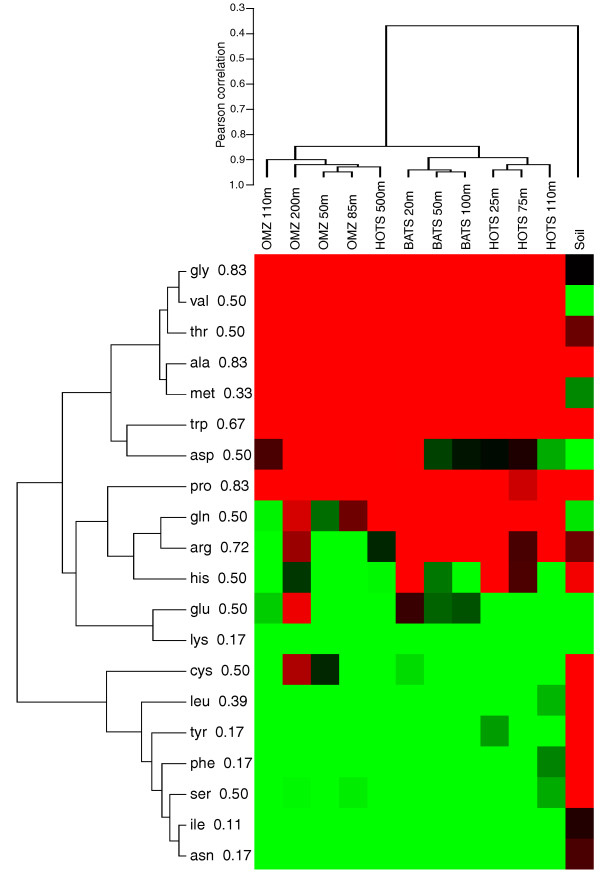
Clustering of sample datasets based on proportional amino acid change. Heat maps show the relative magnitudes of the proportional change (from DNA to RNA) in each sample set. Red = increase, green = decrease, black = zero. Dendrograms are based on hierarchical clustering of Pearson correlation coefficients for each pairwise dataset comparison. Numbers beside amino acid names indicate GC content, calculated as: (Number of GC bases among synonymous codons)/(Number of total bases among synonymous codons).